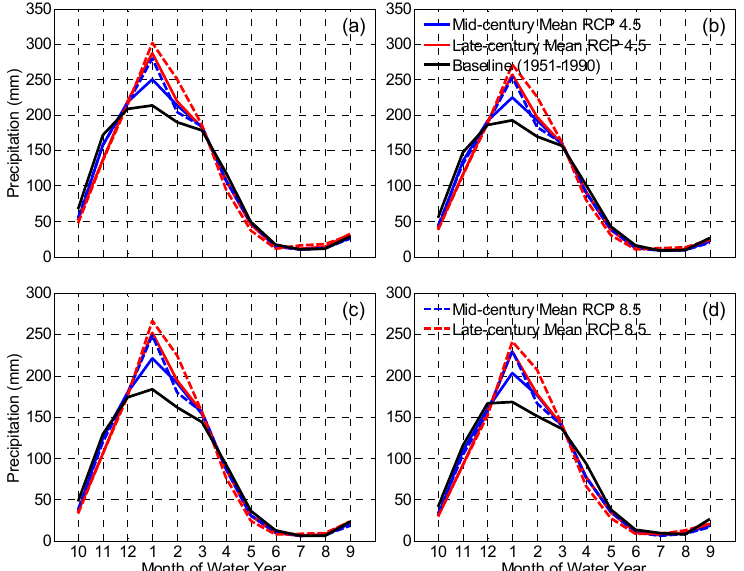
Figure A7. Monthly mean precipitation projections for ( a ) Stanislaus River, ( b ) Tuolumne River, ( c ) Merced River, and ( d ) San Joaquin River under RCP 4.5 and RCP 8.5 projections, respectively.